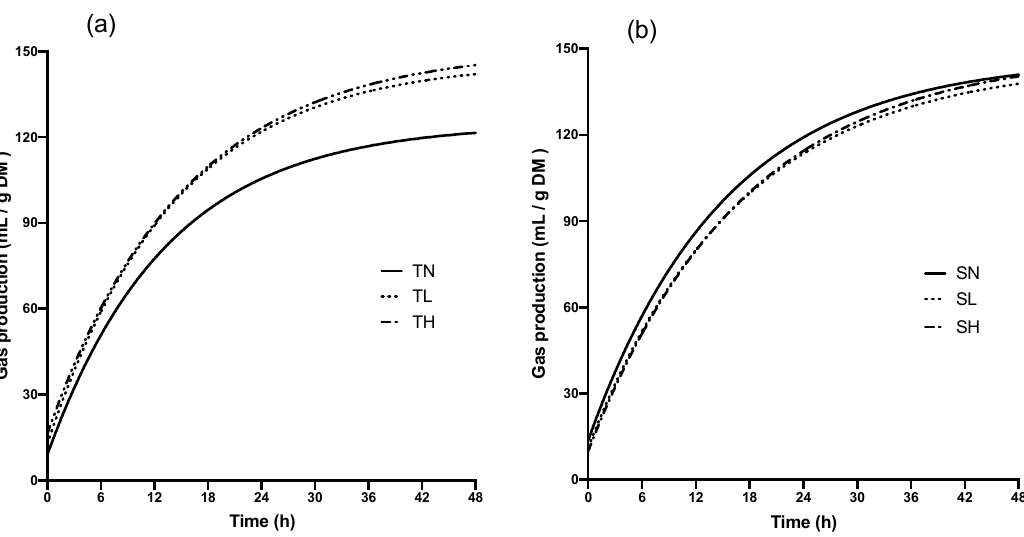
Figure 1. The effect of M ‐ CMS supplementation to diets with or without corn silage on pH during fermentation (Experiment 1). ( a ) Diets without corn silage; ( b ) diets with corn silage. T: forage source without silage; S: forage source contain silage; N: 0% M ‐ CMS; L: 1.75% M ‐ CMS; H: 3.50% M ‐ CMS; M ‐ CMS: molasses + condensed molasses fermentation solubles (1:1 mixture).